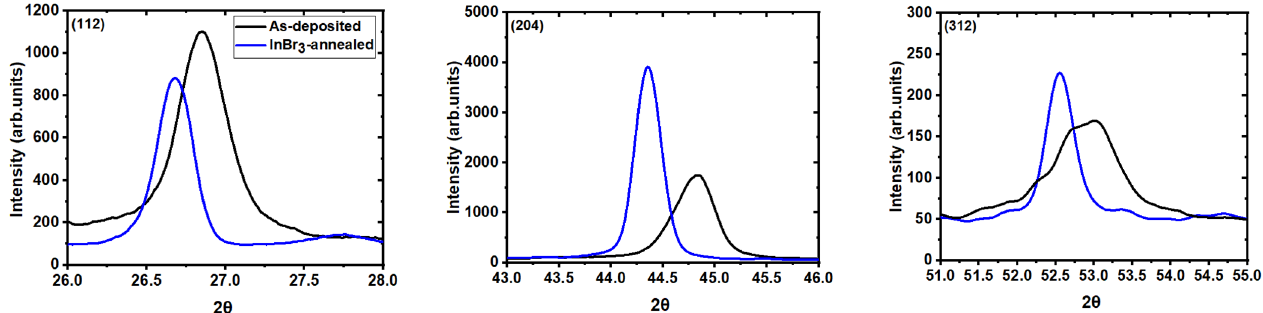
Figure 2. XRD plots of the three key CIGS peaks ((112), (204), and (312)) for the as-deposited (black) and InBr 3 annealed at 400 °C (blue) CIGS samples. Table 1. XRD data analysis, XRF, and Hall effect measurements for the samples annealed at 400 °C.